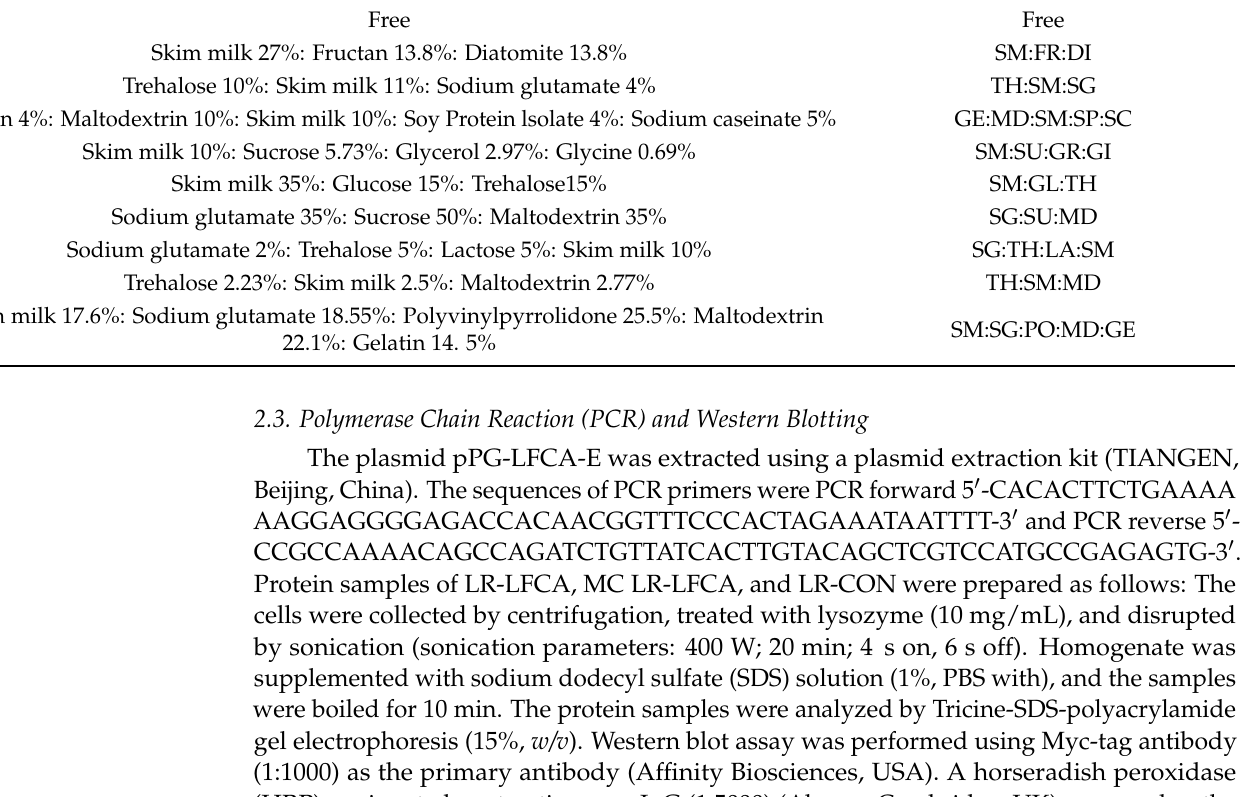
Table 1. Composition of the wall materials used in this study. Wall Materials ( w / w )